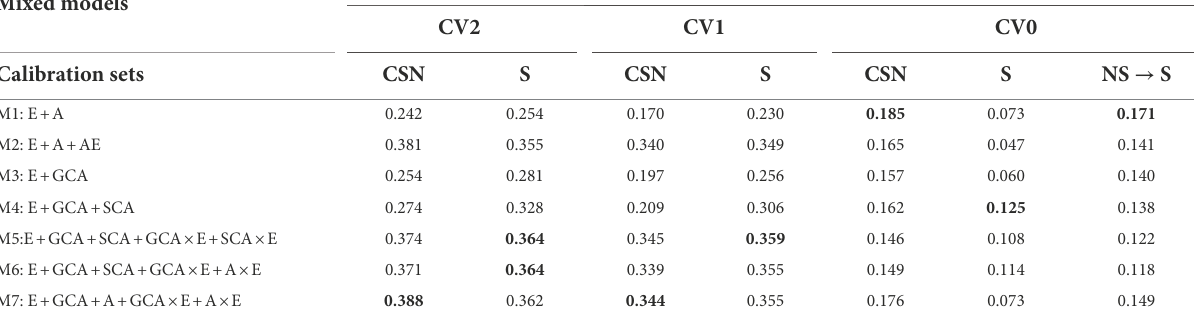
TABLE 2 The predictive abilities for the three selection criterions; CV2, CV1 and CV0 analyzed to predict grain yields under stress (S) conditions using the calibration sets viz., stress dataset alone and Combined [All (stress and non-stress)] (CSN) datasets using seven models.